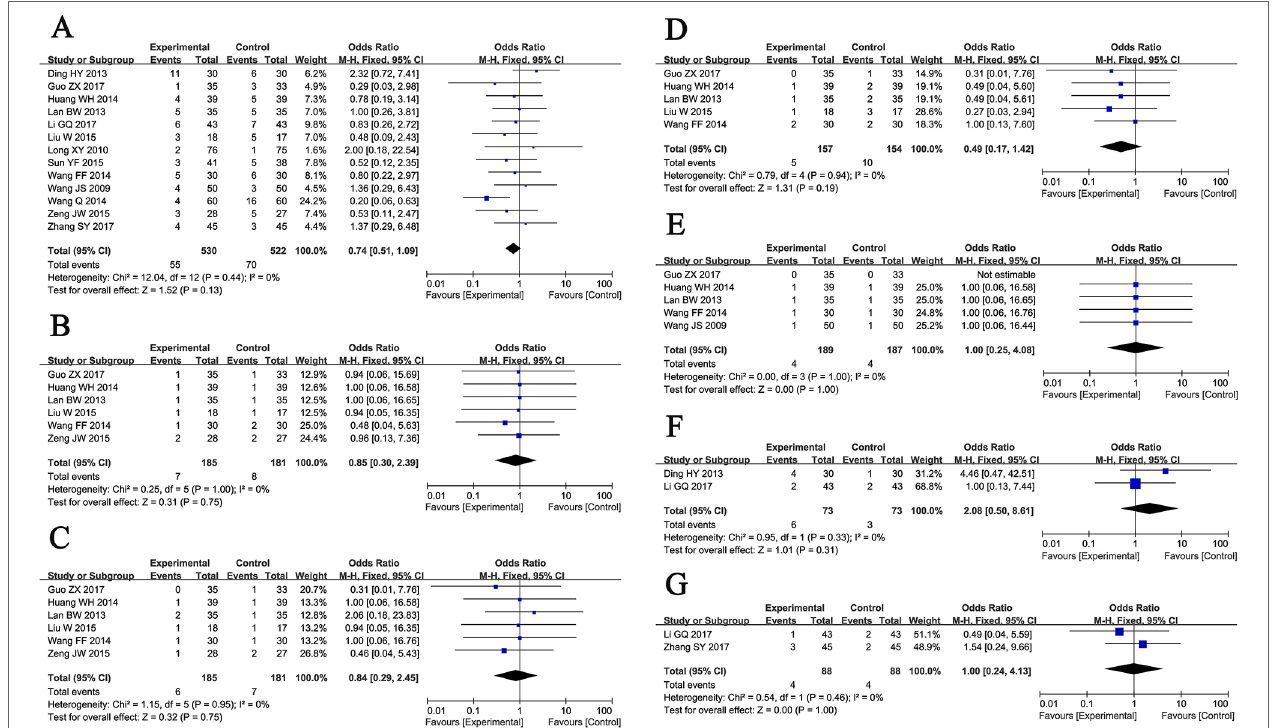
FIGURE 6 | Forest plot of the comparison of adverse effects including total adverse effects (A) , fever (B) , fullness in head (C) , allergy (D) , hemorrhage (E) , palpitation (F) , nausea and vomiting (G) between the experimental and control group. Control group, conventional treatments alone group; Experimental group, conventional treatments and GDI combined group; GDI, Ginkgo leaf extract and dipyridamole injection. The fixed-effects meta-analysis model (Mantel-Haenszel method) was used.